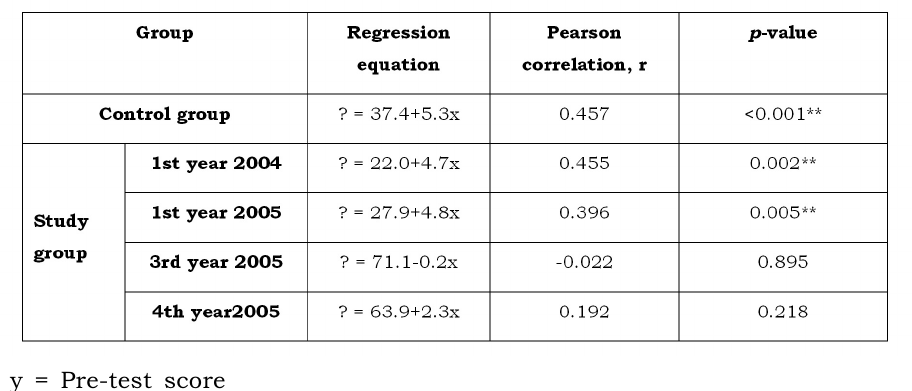
y = Pre-test score